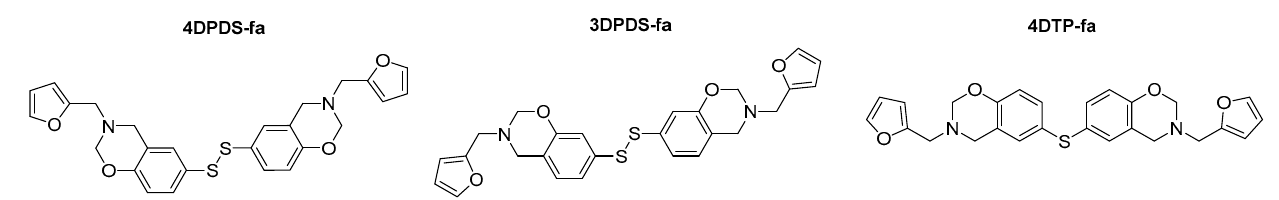
Scheme 1. Schematic representation of novel dibenzoxazines synthesized in this work from 4,4’-dihydroxydiphenyl disulfide (4DPDS), 3,3’-dihydroxydiphenyl disulfide (3DPDS), 4,4 ′ -thiodiphenol (4DTP), and furfurylamine (fa).